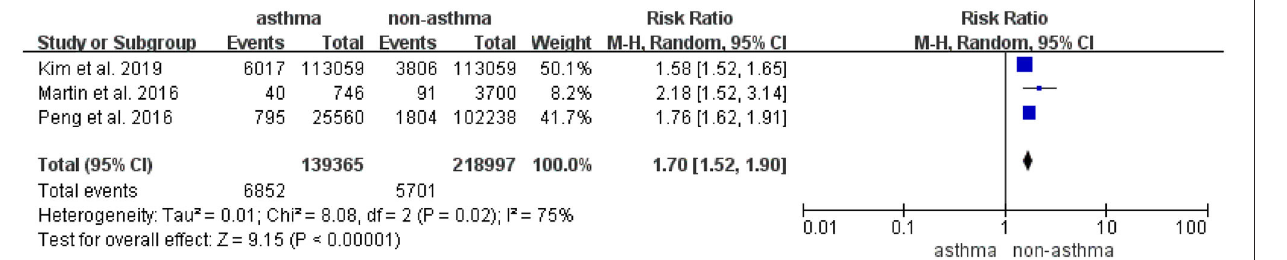
FIGURE 2 | Risk of migraine in patients with asthma in the cohort